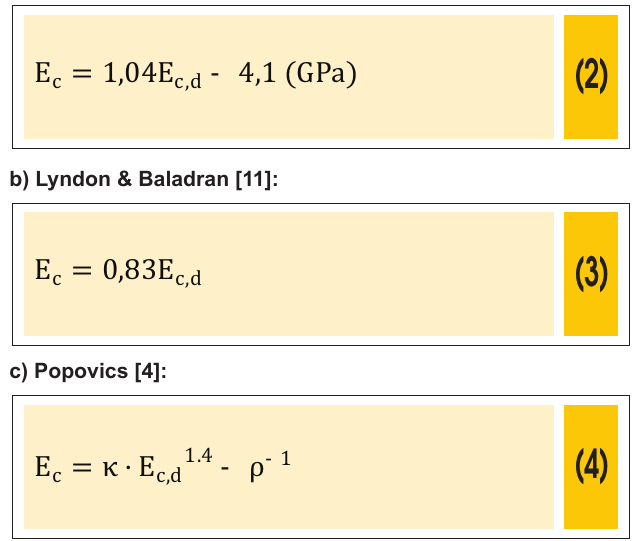
Figure 3 – Relationship between static/dynamic modulus. [4]